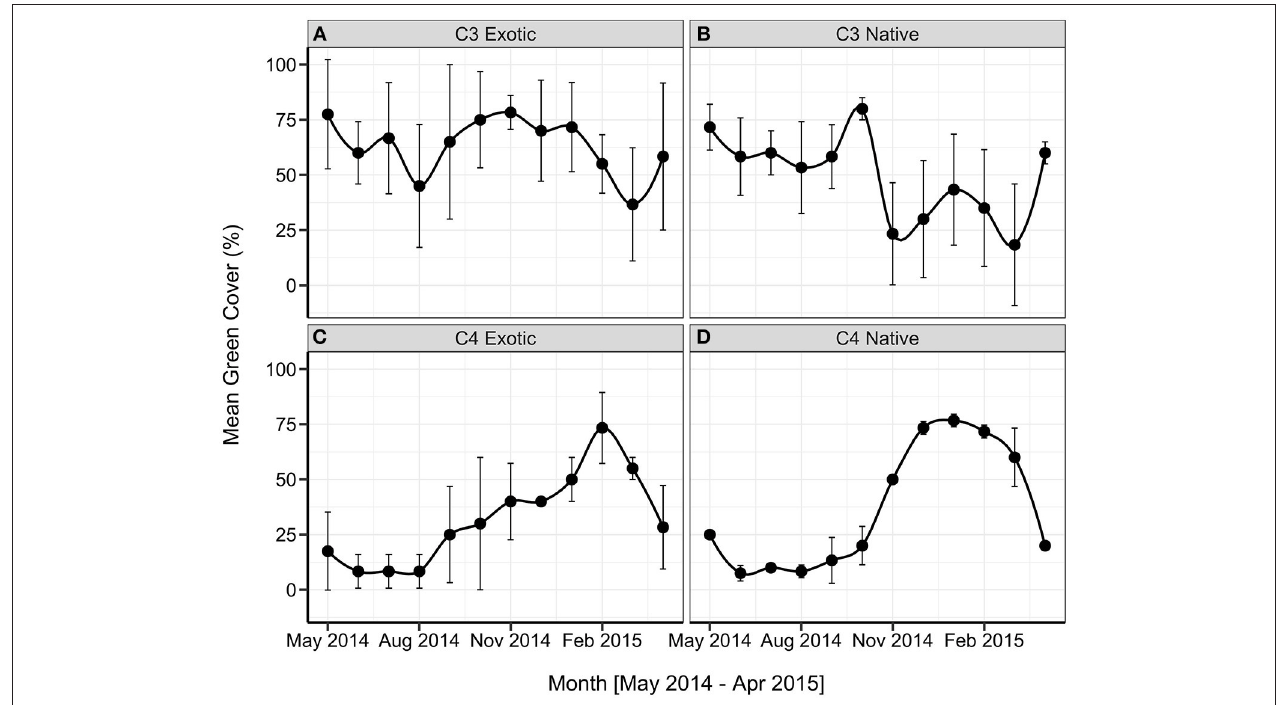
FIGURE 4 | Monthly mean green cover (% ± s.d., n = 3), presented by grassland functional type, (A) C 3 Exotic, (B) C 3 Native, (C) C 4 Exotic, (D) C 4 Native.